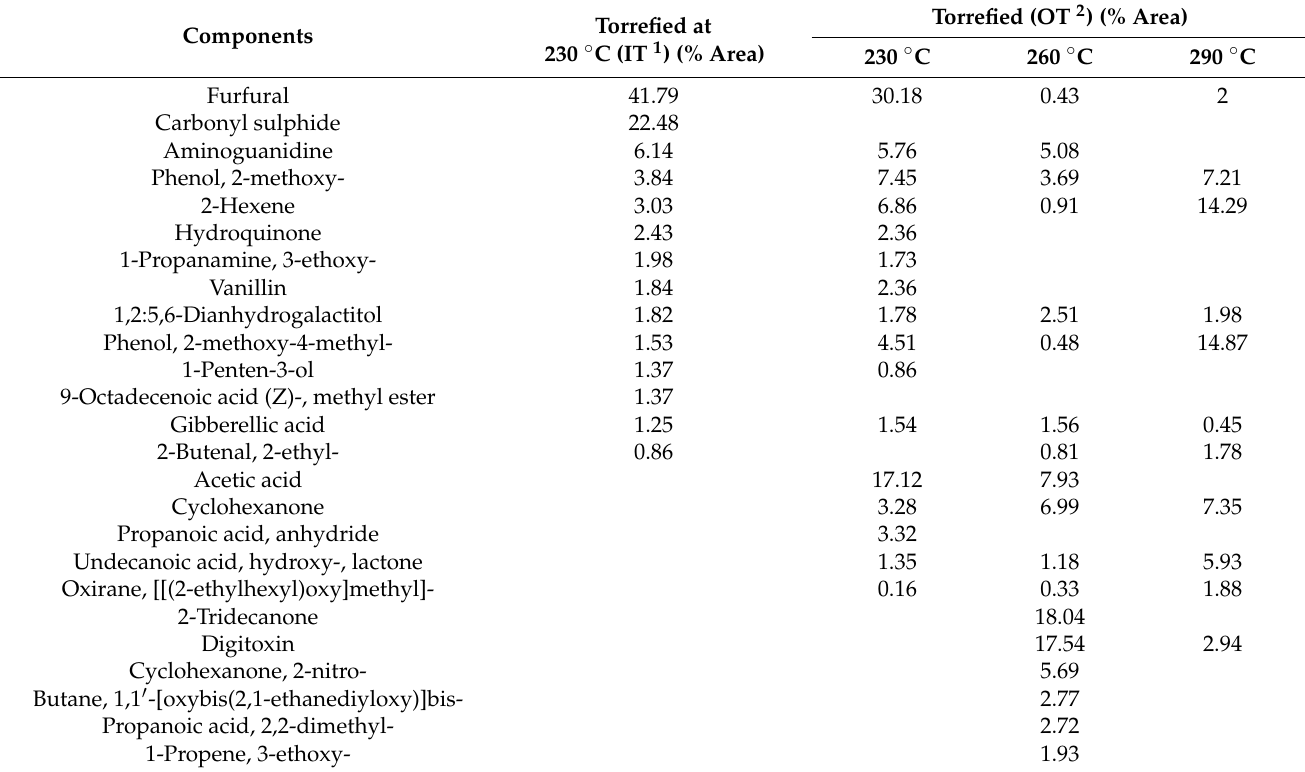
Table 6. Main compounds of torrefaction liquid product from wood sawdust